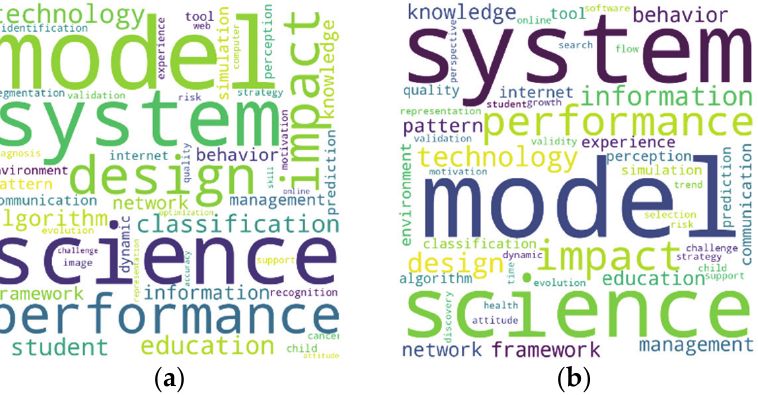
Figure 6. Two word clouds that compare results of the corner centrality value with the 50 most